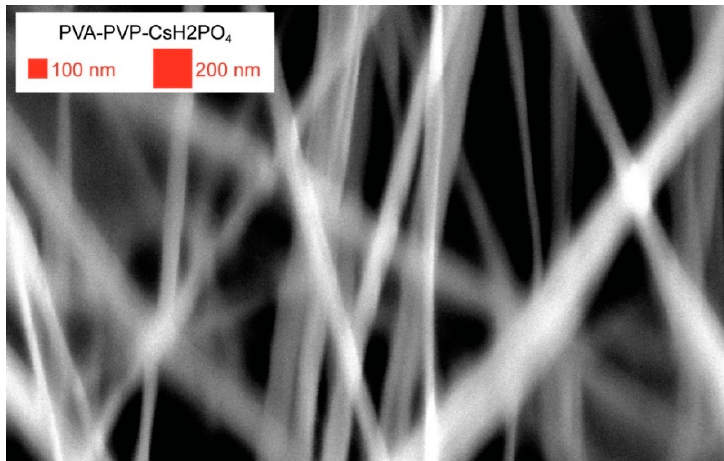
Figure A12. Polyvinyl alcohol- polyvinylpyrrolidone fiber containing conductive CsH 2 PO 4 . The fibers have varying diameters along their length, which we interpret to indicate a ribbon like morphology.